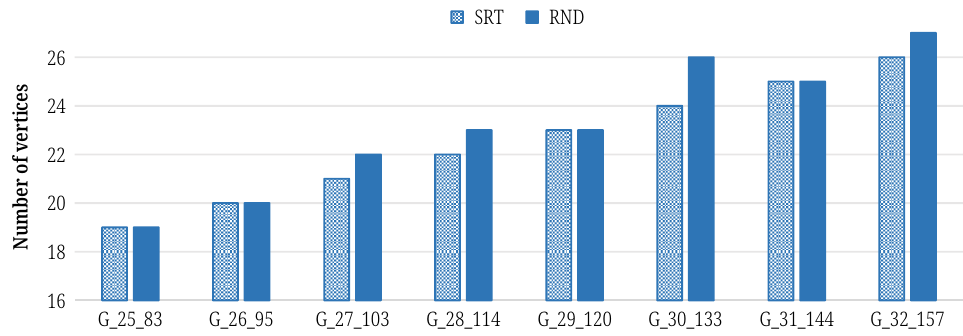
Fig. 9. Comparison between the solution values generated by the two approximate algorithms (for graphs